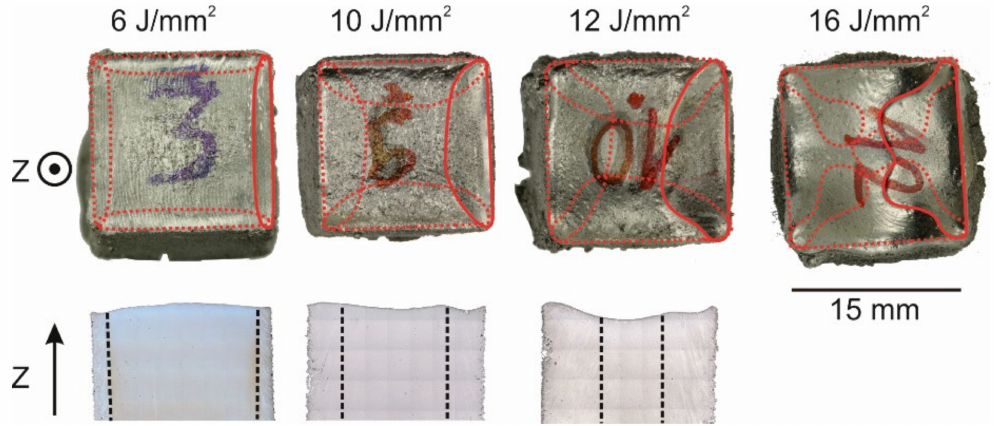
Figure 5. Effect of the energy input beyond the persistent melt pool threshold. Top: Residual melt pool at the surface (red solid line: last melt pool, red dashed line: melt pool from other hatching directions). Bottom: Microstructure with SX core indicated by black dashed lines (the 16 J/mm 2 sample was unstable). (v_Beam: 400 mm/s, hatch distance: 150 µ m, v_lateral: 4